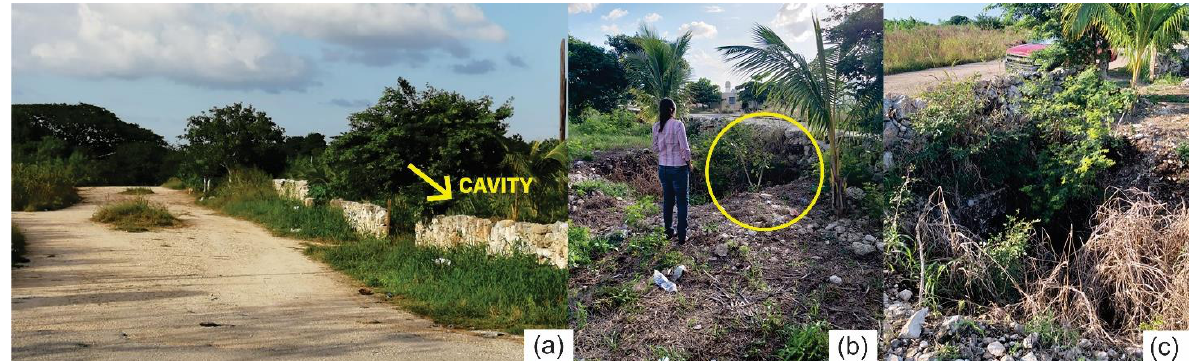
Figure 3. Cavity near roads without special road design in Caucel city, Merida, Yucatan; Mexico. ( a ) Road next to the cavity, ( b , c ) Photography of the cavity